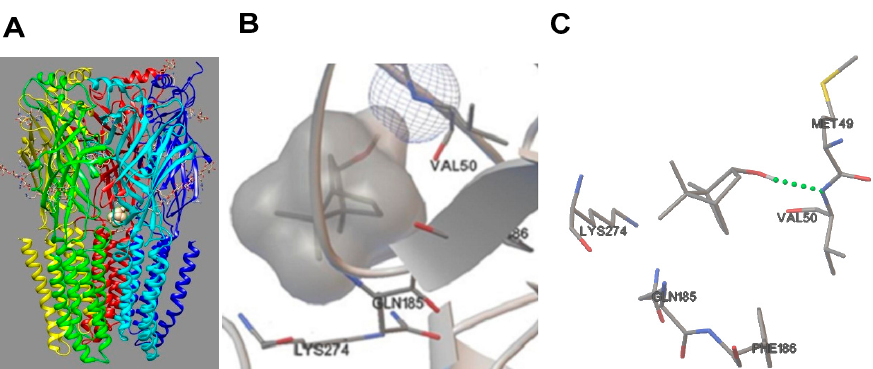
Figure 7. Molecular mapping between (–)-BOR and GABA A R: ( A ) representative frontal image of the interaction between the monoterpene (–)-BOR and GABA A R; ( B ) mesh of energy between molecules; and ( C ) the hydrogen bond between the amino acid Val50 and the molecule of (—)-BOR.